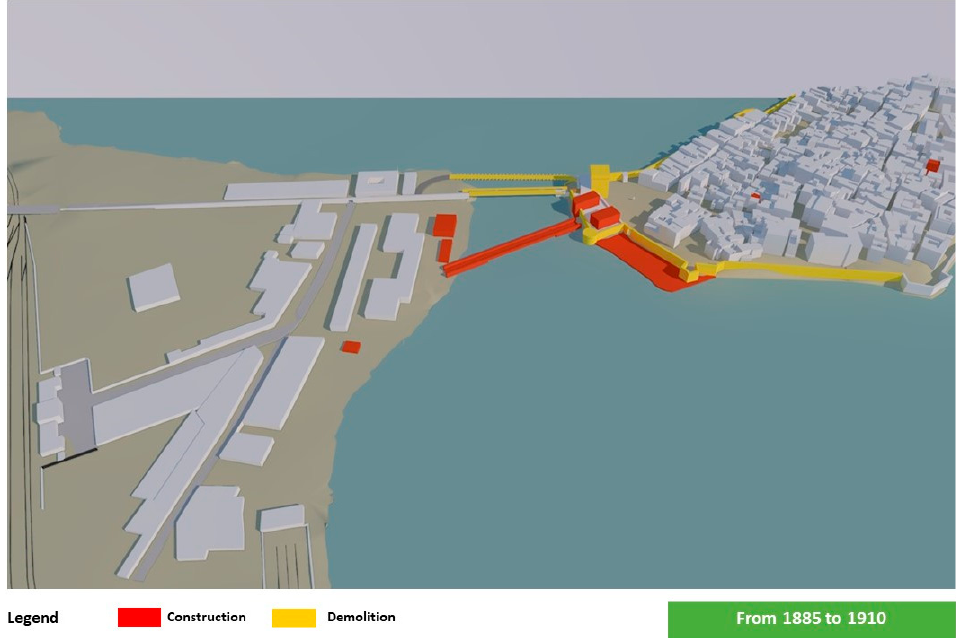
Figure A3. Three-dimensional model of differences between volumes built or demolished—from 1885 to 1910.